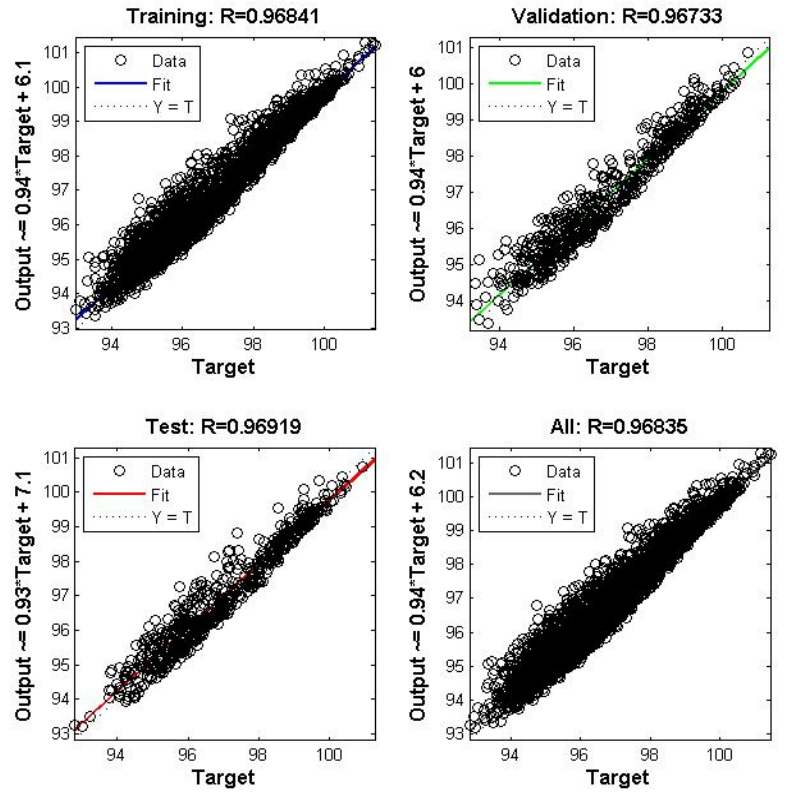
Figure 14. Correlation coefficient for SWSI at station 1 for input model number 3.